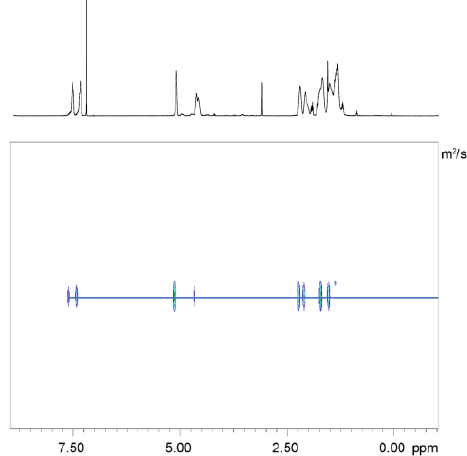
Figure 2. 2D DOSY NMR (600 MHz, CDCl 3 , 298 K) of poly (cyclohexene phthalate-block-cyclohex- ene carbonate) (entry 2 in Table 3).